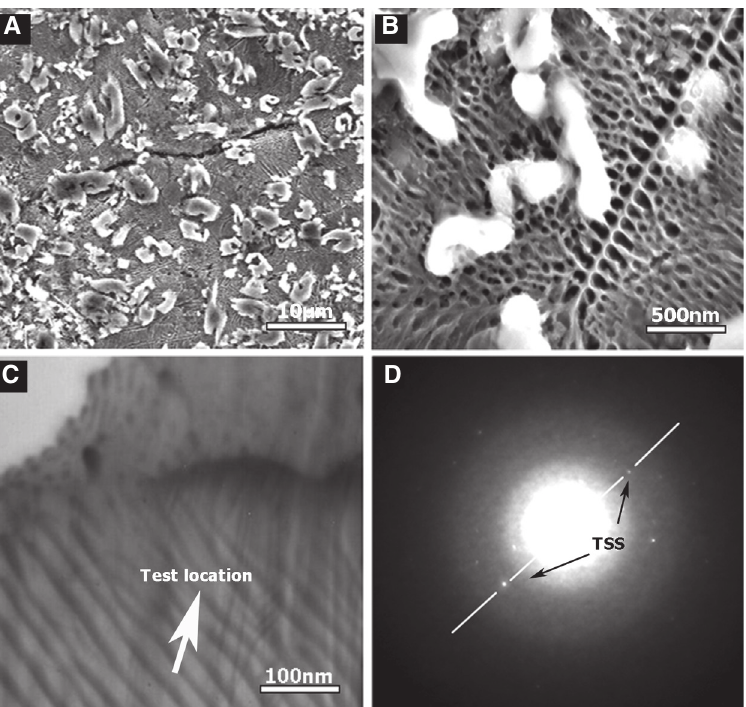
Figure 3 SEM micrographs of the composite coating in samples 2 (A, B), and TEM of ledeburites and its electron diffraction pattern (C,